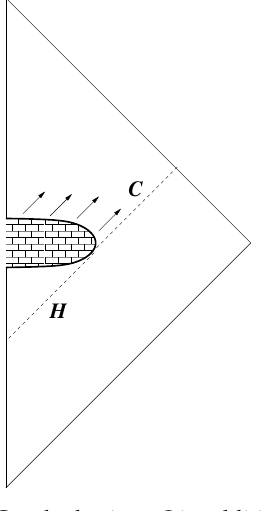
Figure 4. A Euclidean core implies a Cauchy horizon C in addition to the event horizon H , if it opens up in the original exterior. Observers crossing C at low curvature will be exposed to undetermined information from the future boundary of the Euclidean region where new initial values must be posed for the future half of this Penrose